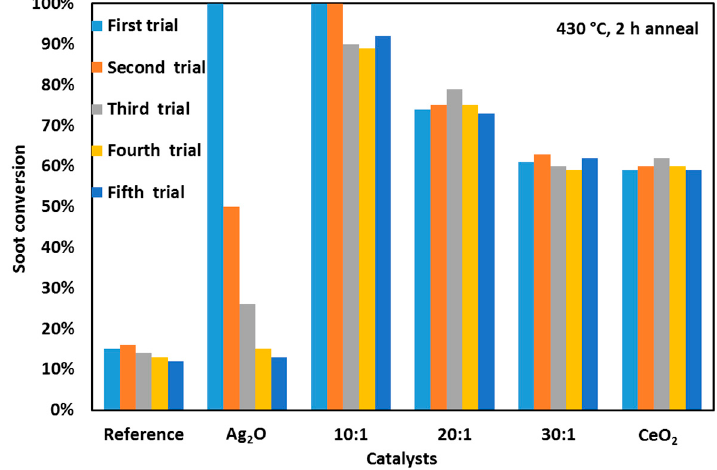
Figure 13. Repetitive soot oxidation in the presence of silver oxide, cerium oxide, and silver doped cerium oxide in ratio CeO 2 :Ag 10:1, 20:1, and 30:1 thin films deposited on stainless steel foil at 200 °C vs. annealing temperature over 2 h at 430 °C.